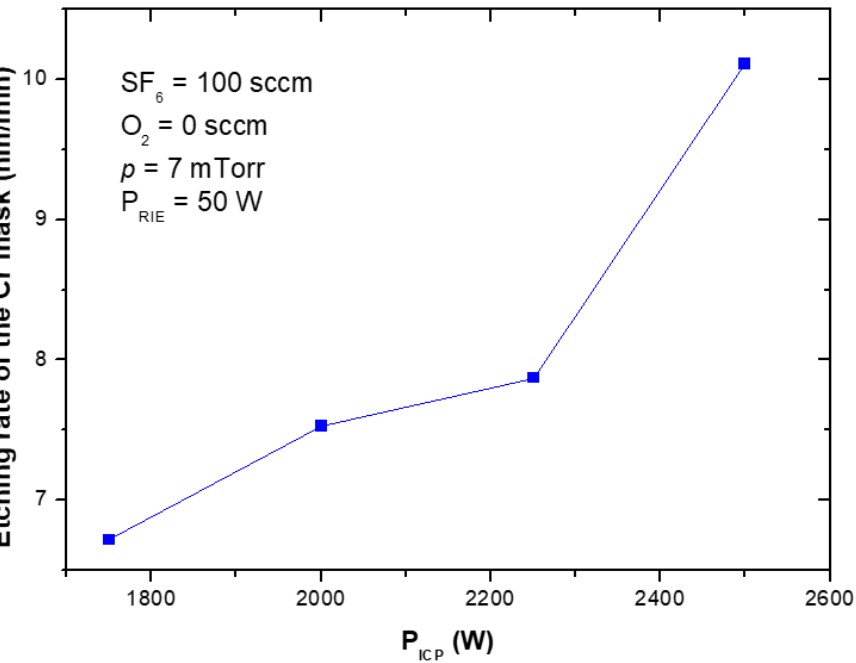
Figure 16. Cr mask etching rate of as a function of ICP power applied. Fixed parameters are included in the inset.